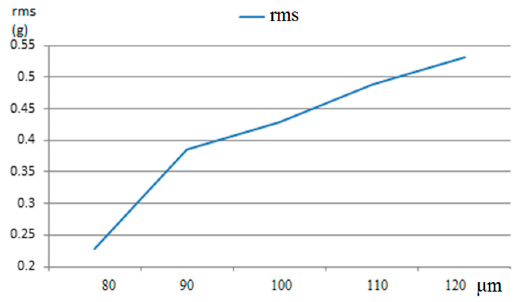
Figure 3. Correlation of depth of cut and cutting vibration for the machining process T03.